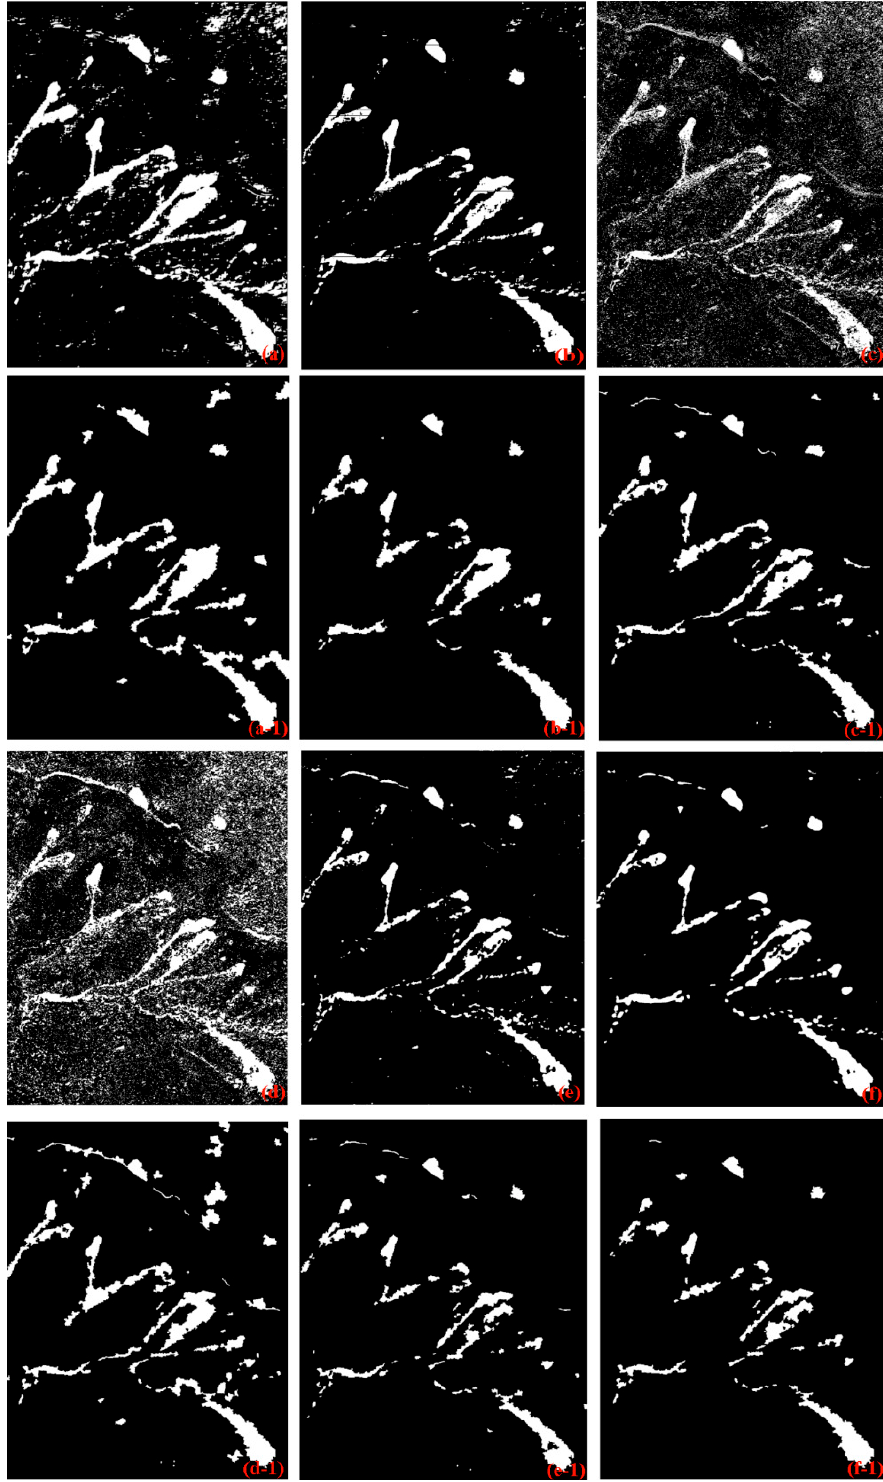
Figure 8. LCCD maps obtained by the preprocessing methods and the proposed OBEM algorithm for the second data set: ( a ) GWDM_EM; ( b ) GWDM_FCM; ( c ) CVA_EM; (a-1) GWDM_EM+OBEM; (b-1) GWDM_FCM+OBEM; (c-1) CVA_EM+OBEM; ( d ) MRF_EM; ( e ) LSELUC; ( f ) PCA_Kmeans; (d-1) MRF_EM+OBEM; (e-1) LSELUC+OBEM; and (f-1) PCA_Kmeans+OBEM.